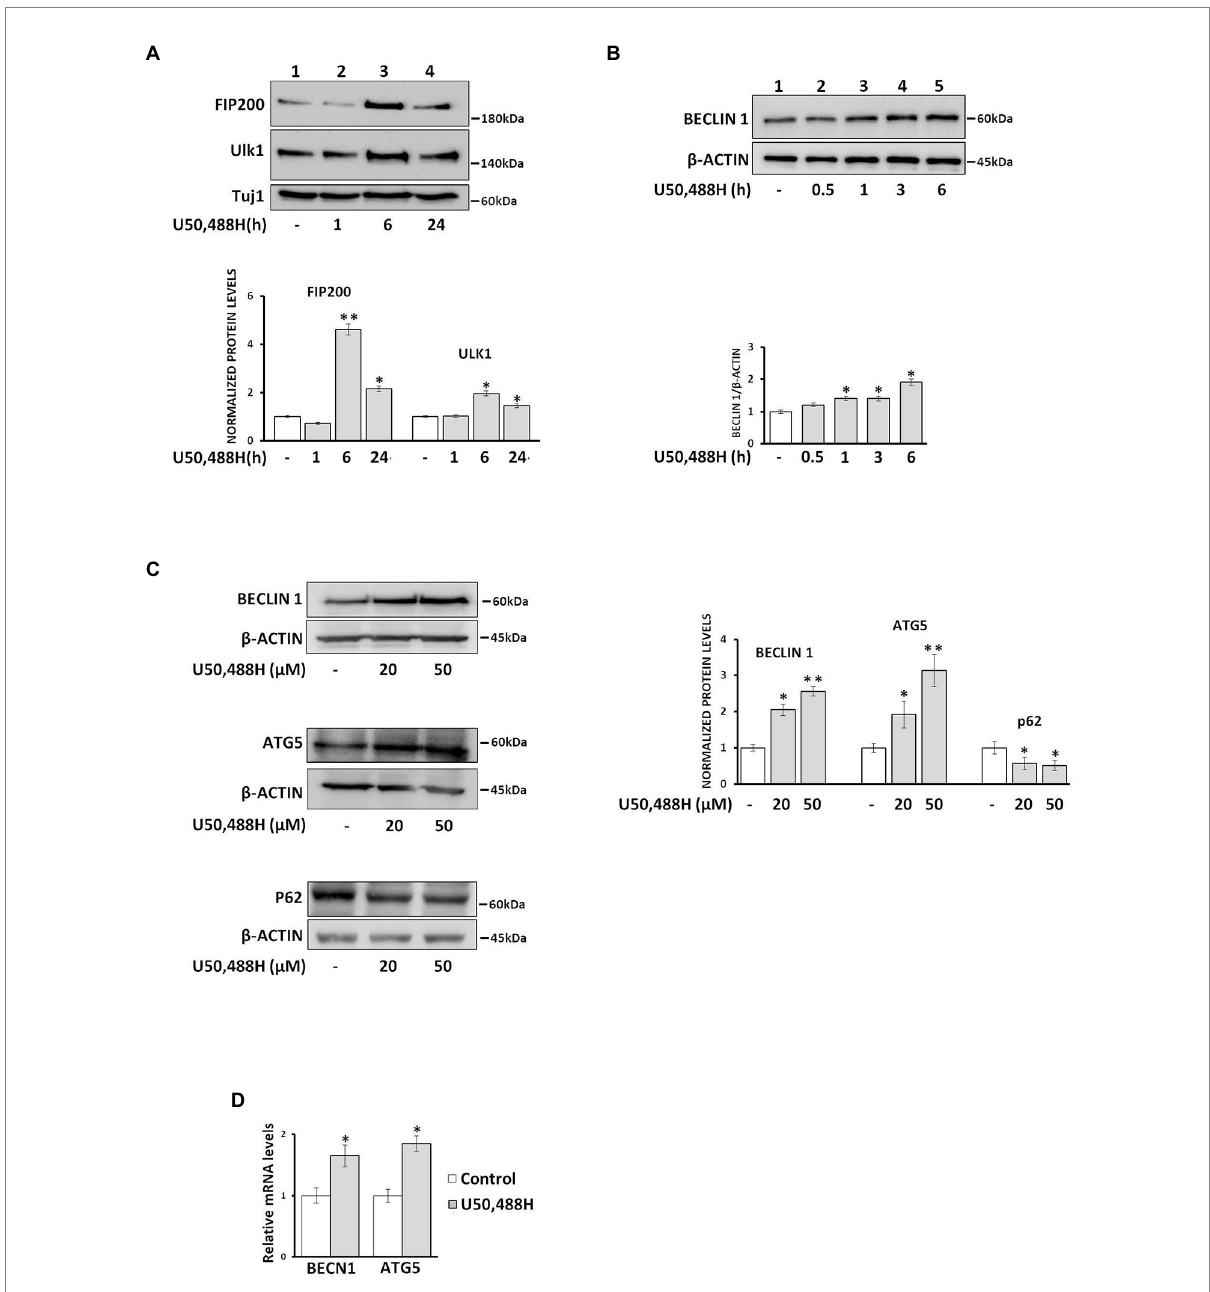
FIGURE 3 U50,488H treatment of neuronal cultures upregulates autophagosome biogenesis. (A) Primary neuronal cultures were treated with 20 μΜ U50,488H for the indicated time intervals and the levels of pre-autophagic markers FIP200 (1:1000) and Ulk1 (1:1000) were identified by western blotting using the corresponding antibodies. Tuj-1 protein levels were used as loading control. (B) Beclin 1 is upregulated in a time dependent manner in κ -Neuro-2A cell lysates upon 20 μΜ U50,488H administration. Beclin 1 levels were normalized to β -actin. (C) The levels of Beclin 1 and ATG5, were increased whereas those of p62 decreased in a dose dependent manner. The protein levels were normalized using β -actin. (D) κ -Neuro-2A cells were treated with 20 μΜ U50,488H for 6 h and the mRNA levels of Becn1 and Atg5 were examined by real-time PCR. Error bars represent average ± S ΕΜ . Statistical analysis was performed using one way ANOVA. All experiments were performed at least three times. * p < 0.05 and ** p < 0.01 as compared with untreated samples.